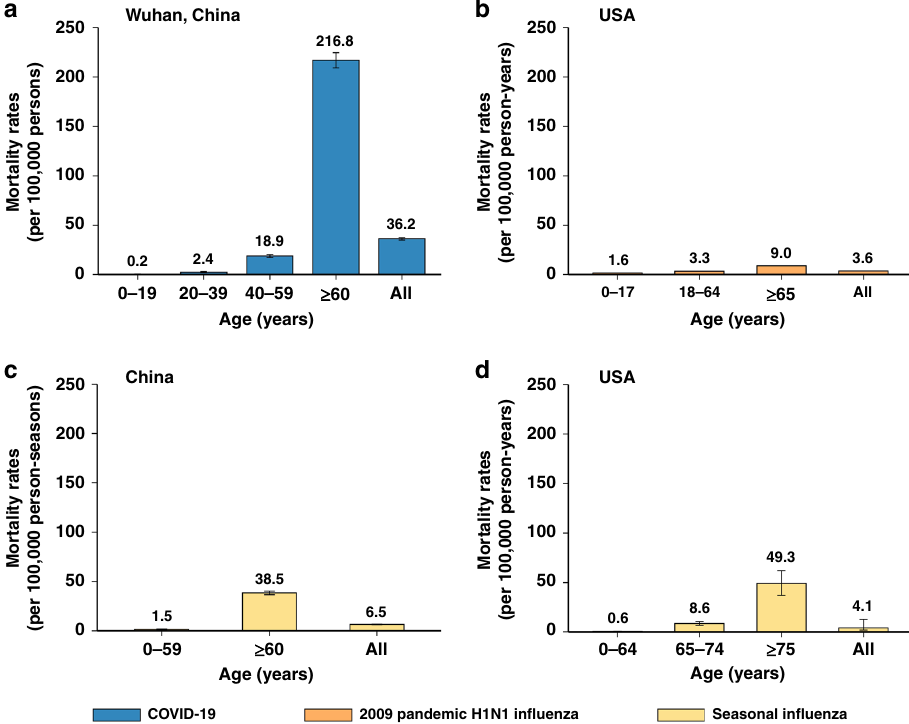
Fig. 4 Mortality rates. a Rates of mortality associated with COVID-19 in Wuhan, China (mean, 95% CI). The error bars presented 95% CI as estimated using Monte Carlo sampling (10,000 samples from Binomial distributions). b Rates of mortality associated with 2009 pandemic H1N1 in fl uenza, USA (75% percentile) 20 . c Excess mortality rates associated with seasonal in fl uenza, China (mean, 95% CI) 21 . d Excess mortality rates associated with seasonal in fl uenza, USA (median, 95% credibility interval) 22